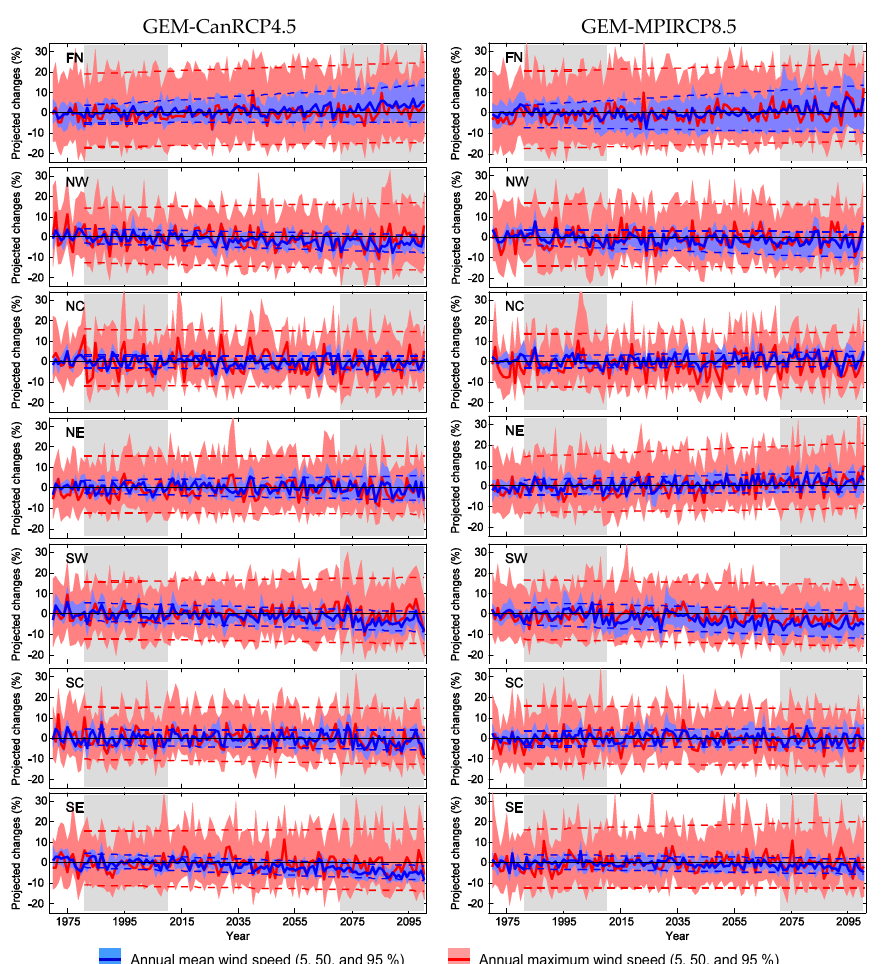
Figure 8. Projected changes to the annual mean (blue) and maximum (red) wind speeds with respect to the mean values for the current 1981–2010 period for GEM-CanRCP4.5 (first column) and GEM-MPIRCP8.5 (second column) for the seven sub-regions (shown in Figure 5a) of North America. Lower and upper boundaries and solid lines respectively represent the 5th, 95th, and 50th percentiles of the projected changes from the grid points located in each sub-region. Blue and red dotted lines represent linear trends of the 5th and 95th percentiles of the projected changes. Current and future analysis periods are indicated with grey background.